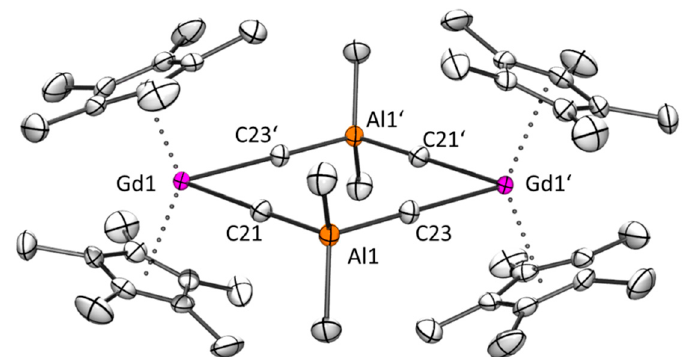
Figure 10. ORTEP view of the crystal structure of [Cp* 2 Gd(AlMe 4 )] 2 ( 4 Gd ). Atomic displacement parameters are set at the 50% probability level. Hydrogen atoms and one molecule of n -hexane per asymmetric unit are omitted for clarity. See Table 6 for significant bond lengths and angles.